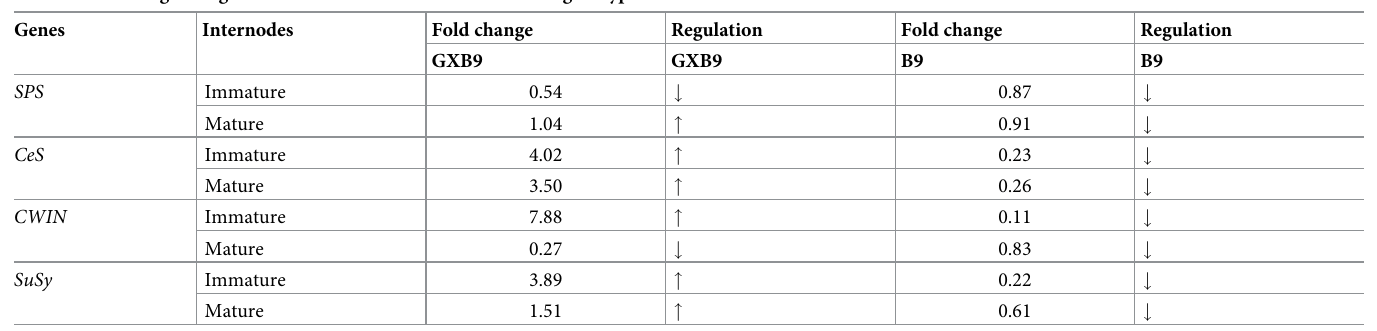
Table 6. Relative gene regulation in GXB9 mutant and B9 mother genotype. Genes